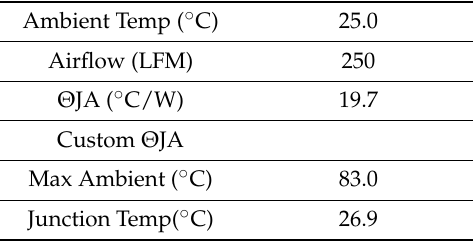
Table 5. Thermal summary of the proposal